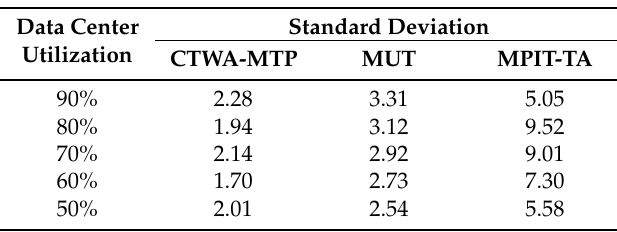
Table 2. The standard deviation of chip